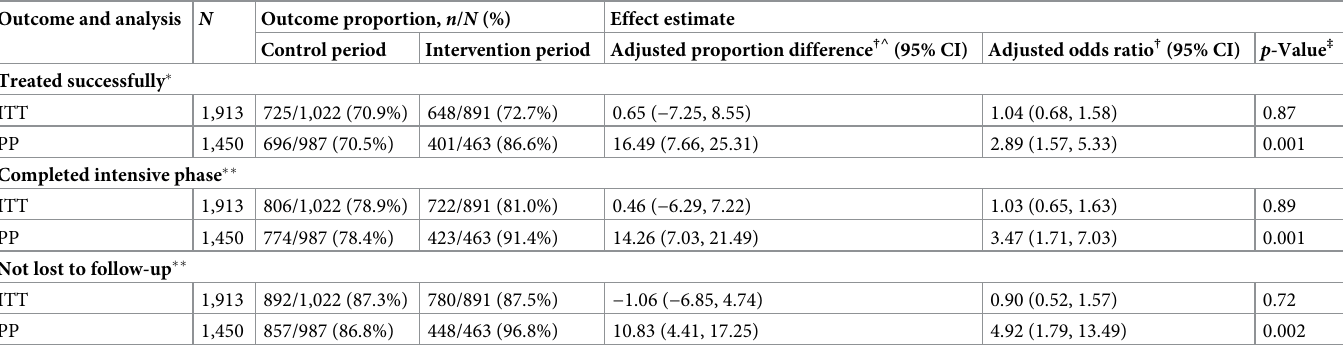
Table 2. Effectiveness of the 99DOTS-based intervention. Outcome and analysis N